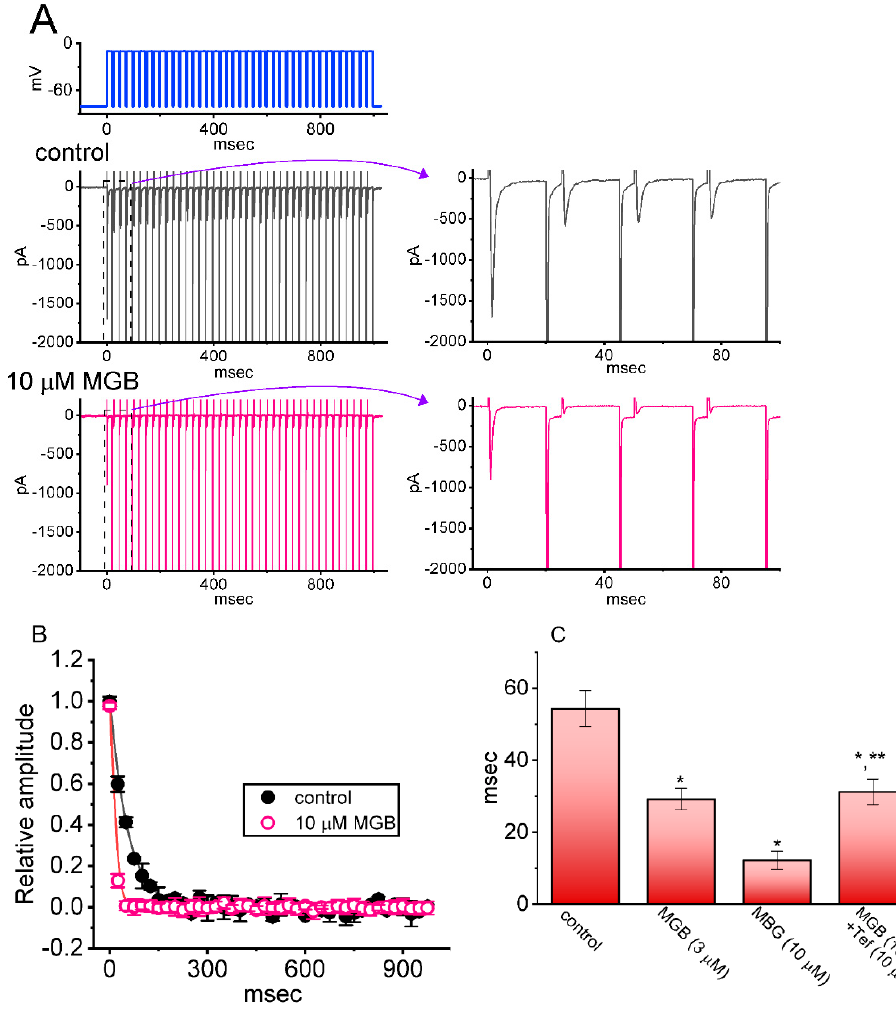
Figure 8. Effect of MGB on I Na(T) activated by a train of depolarizing pulses in GH 3 cells. The train was designed to consist of 40 20 ms pulses (stepped to − 10 mV) separated by 5 ms intervals at − 80 mV for a duration of 1 s. ( A ) Representative current traces taken in the control period (a, absence of MGB) and during cell exposure to 10 μ M MGB. The voltage-clamp protocol is illustrated in the uppermost part. To provide a single I Na trace, the right side of ( A ) denotes the expanded records from the dashed box of the left side. ( B ) The relationship of peak I Na ( I Na(T) ) versus the pulse train duration in the absence (filled black circles) and presence (open pink circles) of 10 μ M MGB (mean ± SEM; n = 7 for each point). The continuous smooth lines over which the data points are overlaid are well-fitted by a single exponential. Of note, the presence of MGB can quicken the time course of I Na(T) inactivation in response to a train of depolarizing pulses. ( C ) Summary bar graph showing the effect of MGB and MGB plus tefluthrin (Tef) on the time constant of current decay in response to a train of depolarizing command voltage from − 80 to − 10 mV (mean ± SEM; n = 7 for each bar). Current amplitude was measured at the beginning of each depolarizing pulse. Of note, the presence of MGB produces a significant shortening in the time constant in the decline of peak I Na activated by a train of pulses. * Significantly different from control ( p < 0.05) and ** significantly different from MGB (10 μ M) alone group ( p < 0.05).